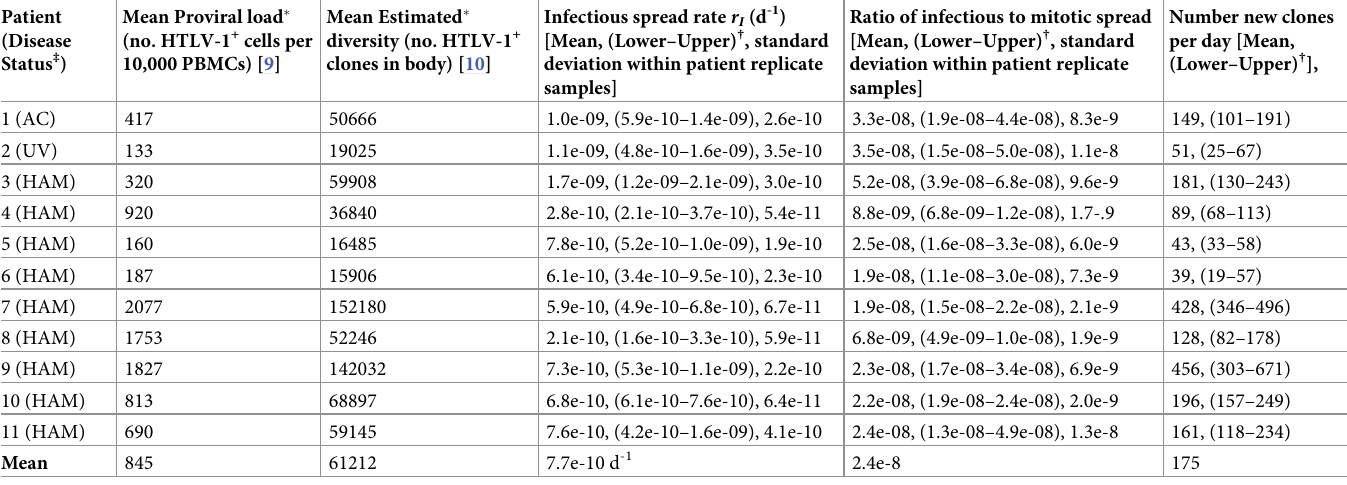
� Mean value of nine replicate samples for each patient (see methods) † Lower and Upper denote the range of estimates from nine hybrid model fits from each subject. ‡ Disease status: AC = asymptomatic carrier. UV = uveitis (non-HAM/TSP); HAM =